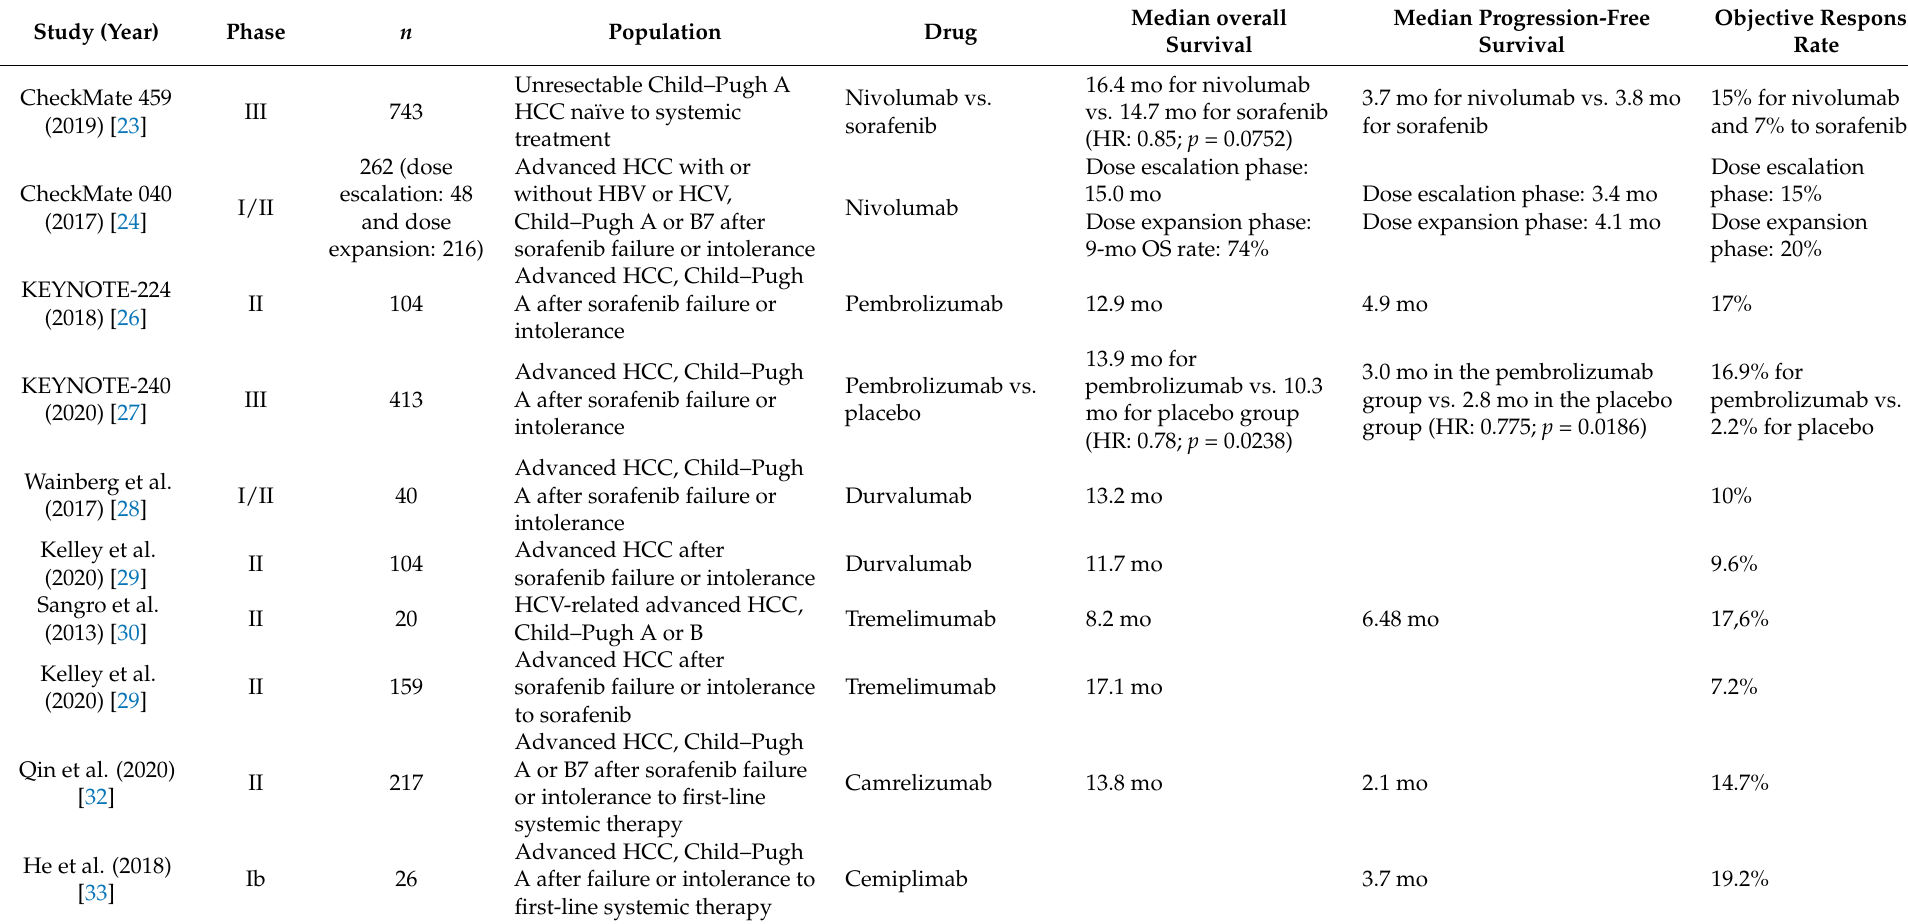
Table 1. Results of selected studies testing immune checkpoint inhibitors in advanced HCC